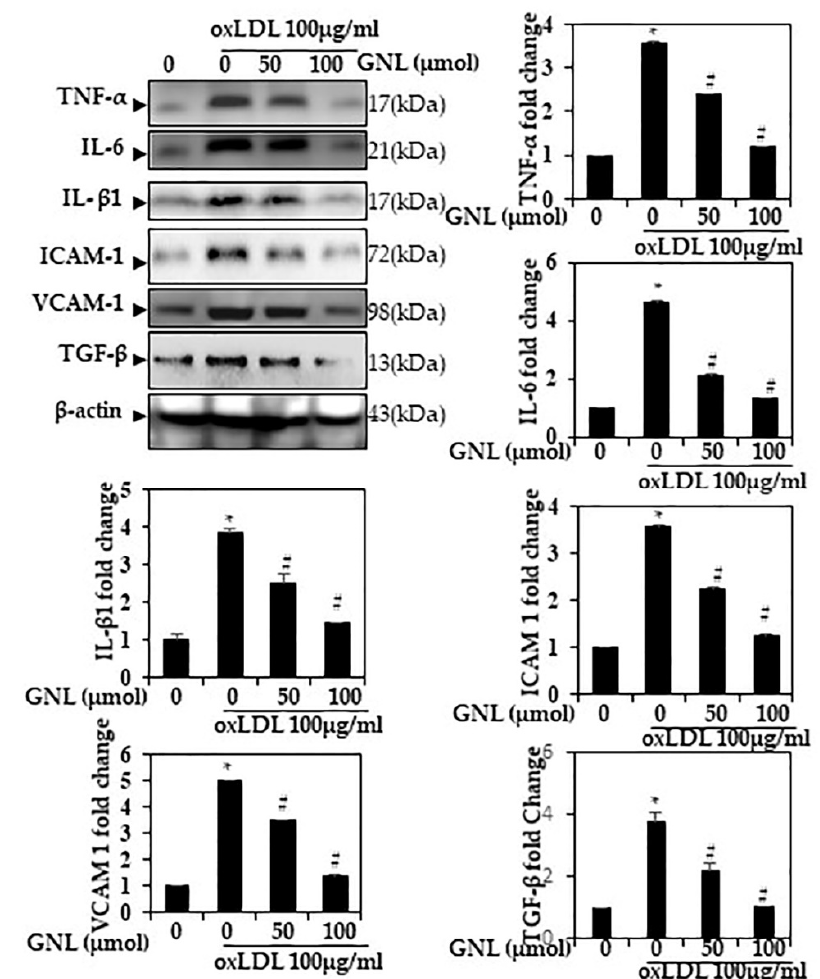
Figure 3. GNL mitigated Ox-LDL-induced cytokine production in endothelial cells. HUVECs were treated with GNL and/or Ox-LDL for 24 h. Expression of TNF- α ,IL-6,IL-1 β , ICAM-1, VCAM-1 and TGF- β protein was assessed by Western blotting. There are three replicates of each value, and * p < 0.05 represents a significant difference when compared to the control group. A # represents p < 0.05; thus, significant differences between the Ox-LDL alone and GNL with Ox-LDL treatment groups.